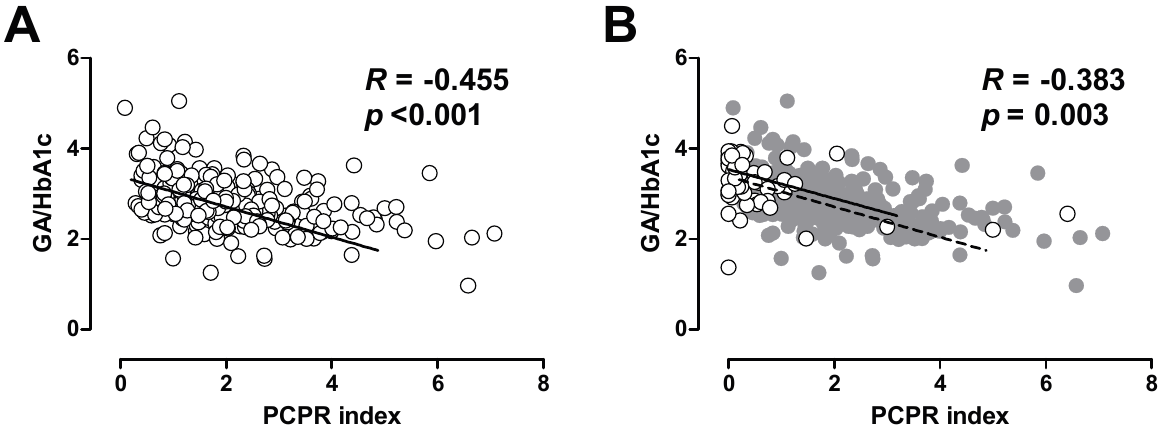
Figure 3. Correlation between postprandial C-peptide index (PCPRI) and glycated albumin (GA) to HbA1c ratio in patients with type 2 diabetes ( A ) and type 1 diabetes ( B ). ( B ) The data of patients with type 1 diabetes are superimposed on the data of those with type 2 diabetes (gray circles and dotted line). Reproduced with permission from the Japan Diabetes Society